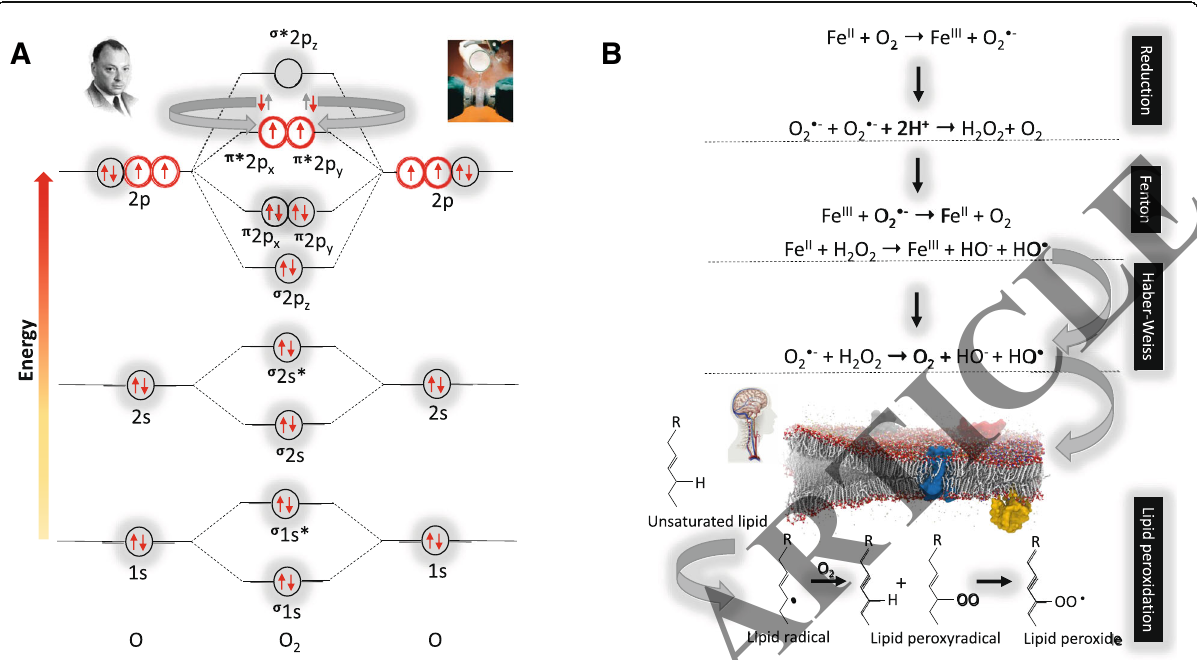
Fig. 3 a Molecular orbital diagram of the most stable form (electronic ground state) of the diatomic oxygen molecule ( 3 ∑ g − O 2 ) and b . Biological reactions underpinning oxygen toxicity. a Each line represents a molecular orbital and the arrows represent electrons, the direction of which indicates their spin quantum number. Note that oxygen (O 2 ) with an electronic structure of 1s 2 2s 2 2p 4 qualifies as a di-radical since it contains two unpaired electrons each occupying different π * 2p anti-bonding orbitals (highlighted in red) with the same spin quantum number (parallel spin) in accordance with Hund ’ s rule. It is for this reason that O 2 is paramagnetic allowing liquid O 2 to hang magically suspended between the poles of a magnet (upper right insert). During the process of oxidation when O 2 looks to accept a (spin opposed) pair of electrons ( ), only one of the pair ( ) can “ fit ” into each of the vacant π * 2p anti-bonding orbitals to create a spin opposed pair (as indicated). Hence, O 2 thermodynamically prefers to accept only one electron at a time to conform with the Pauli Exclusion Principle [named after the Nobel Prize winning work of the Austrian physicist Wolfgang Pauli (1900 – 1958), photograph upper left insert]. Fortuitously, this “ spin restriction ” means that O 2 reacts “ sluggishly ” with the brain ’ s organic compounds with the organic donor having to undergo a “ slow spin inversion ’” to donate its electrons. b Three types of reactions lead to the superoxide anion (O 2 (cid:129) − )-mediated formation of the damaging hydroxyl radical (HO (cid:129) ) capable of causing indiscriminate damage to biological cell membranes that characterizes O 2 toxicity; [1] one-electron reduction of molecular O 2 to O 2 (cid:129) − catalyzed by transition metals including iron (Fe), [2] Fenton reactions that involve metal-catalyzed formation of HO (cid:129) and [3] Haber-Weiss reaction involving the combination of O 2 (cid:129) − and hydrogen peroxide (H 2 O 2 ) to yield additional HO